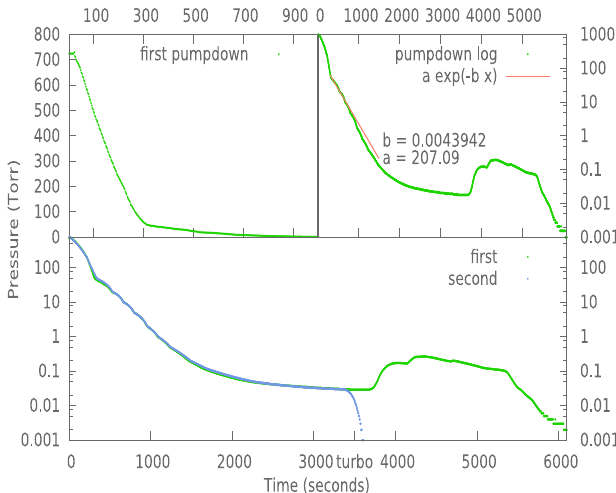
FIG. 6. Evolution of the pressure in the turbo chamber as a function of the time for SUGAR system (see the text for details).